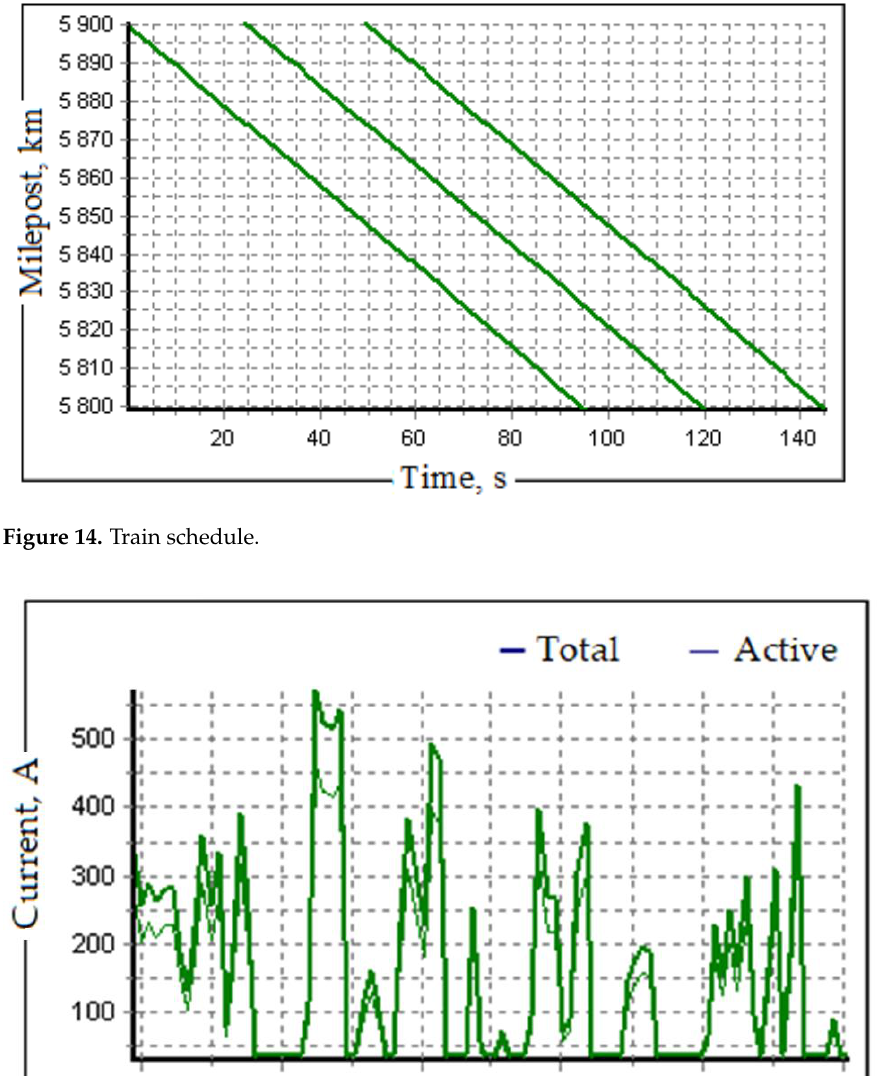
Figure 13. Detail of the computational model circuit.